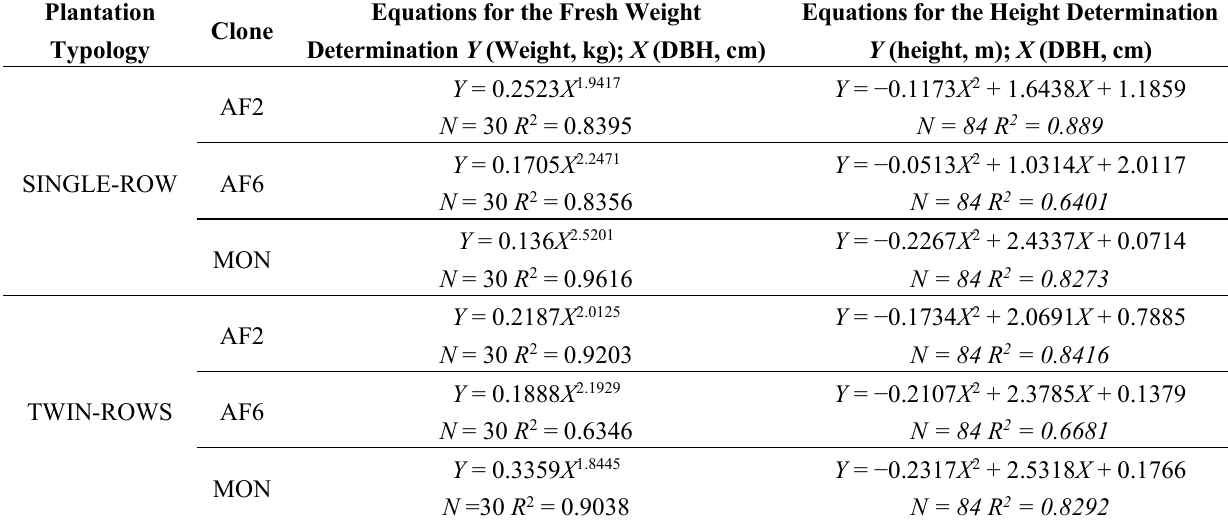
Table 1. Equations to determinate height (m) and weight (kg) as a function of DBH for each clone and plantation typology (single- and